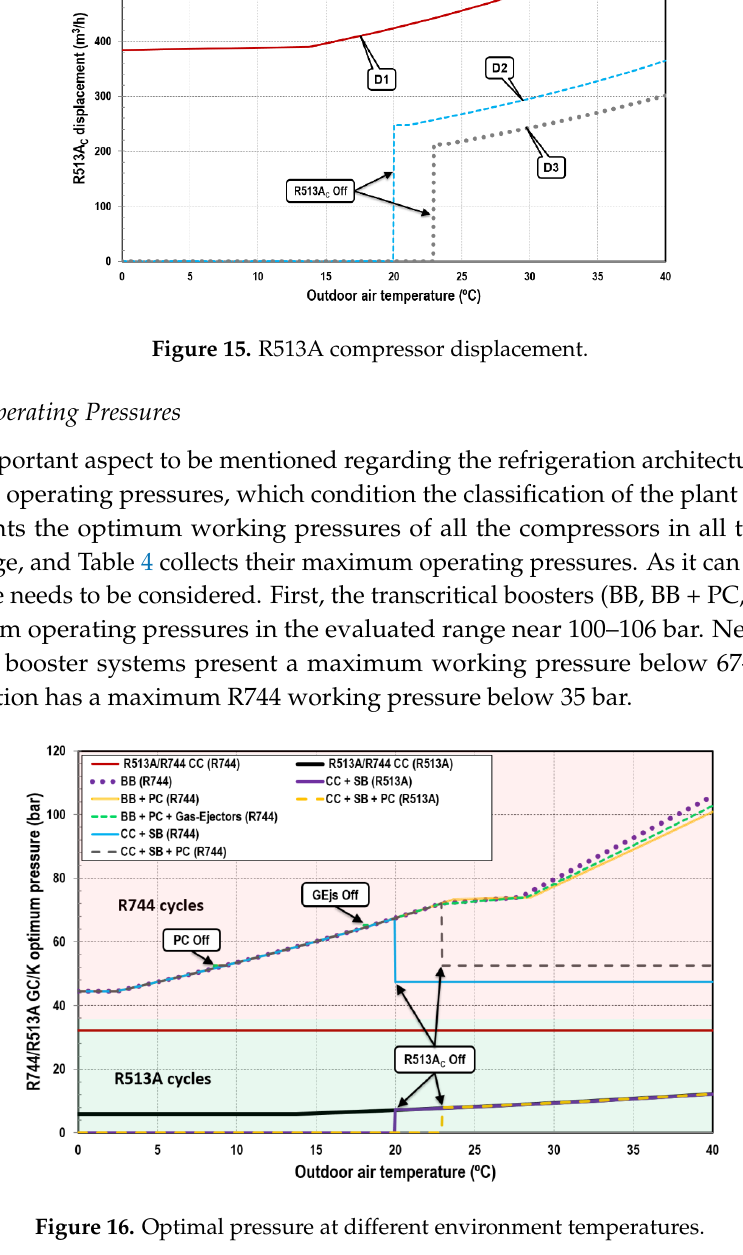
Figure 16. Optimal pressure at different environment temperatures.